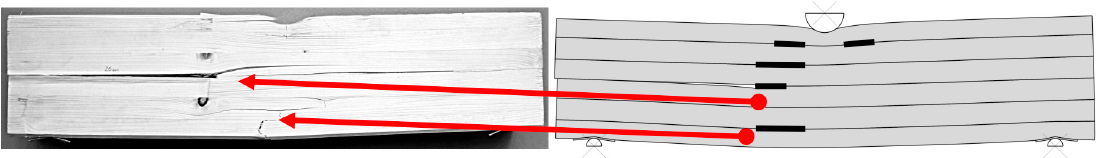
Figure 13. Adhesive delamination identification.